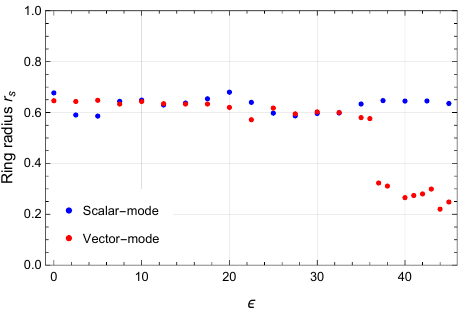
Figure 17 . The (cid:15) dependence of an image amplitude. Blue points and red points cor- respond to a scalar-mode and a vector-mode perturbation